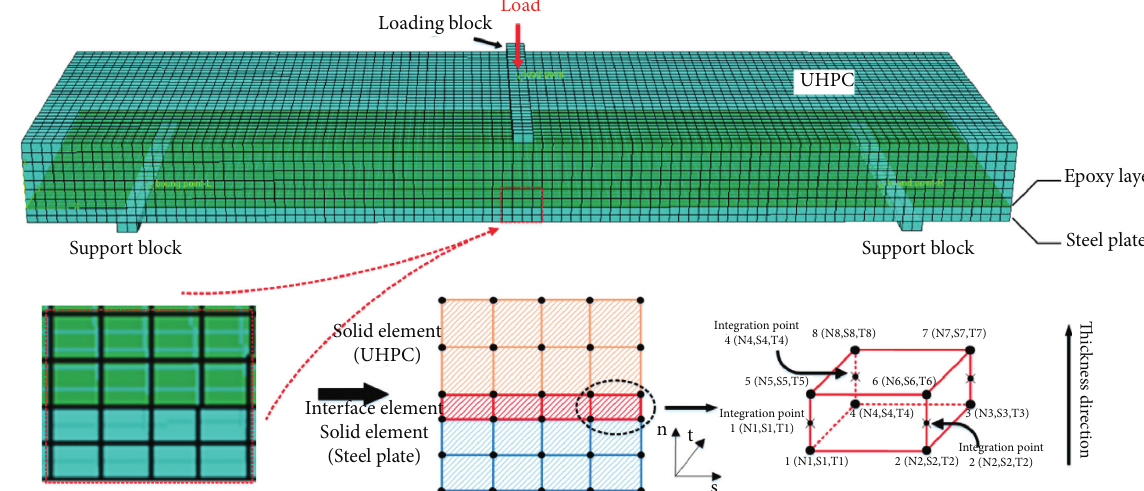
Figure 11: Zero-thickness cohesive interface element (COH3D8).